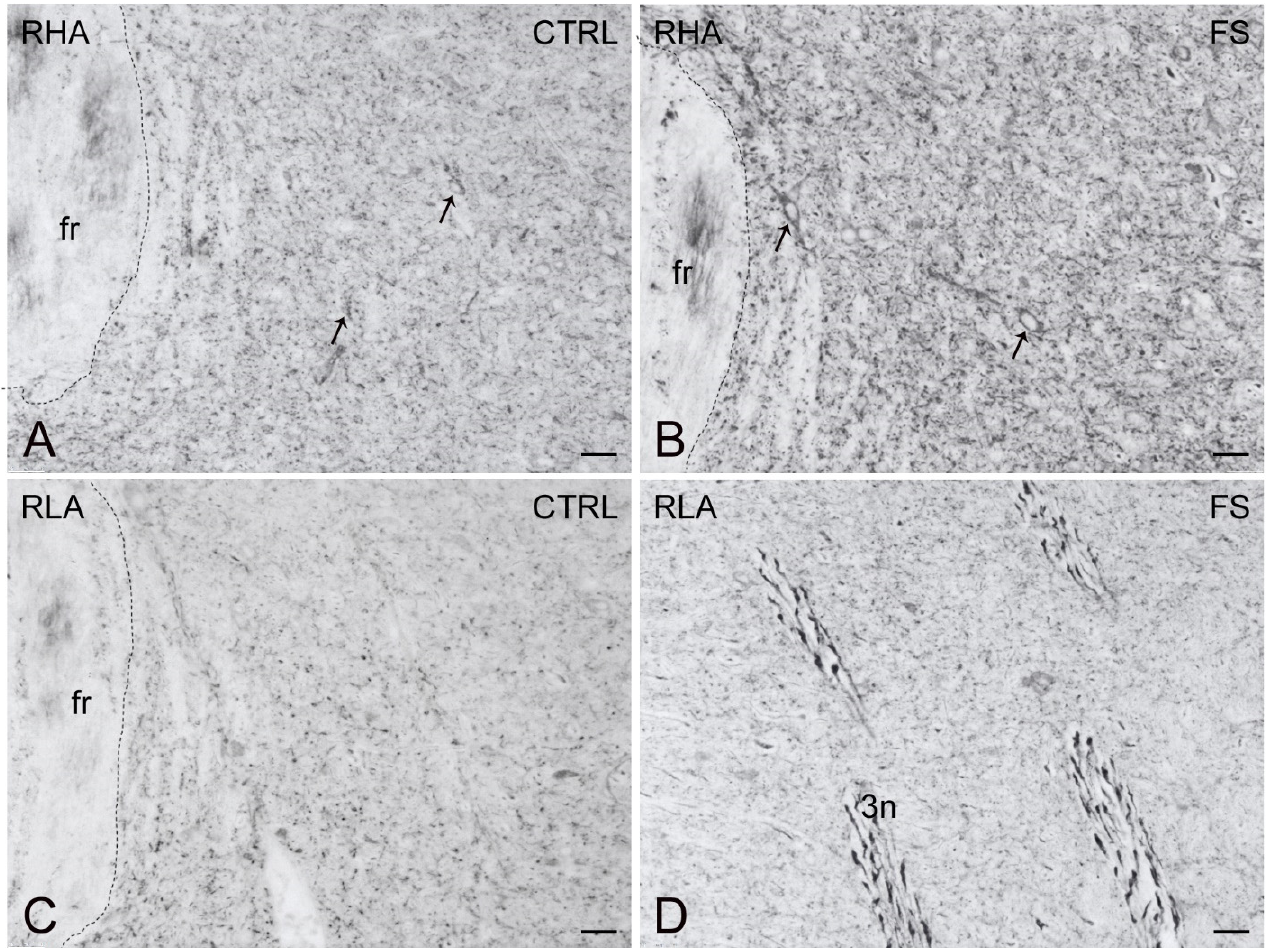
Figure 10. trkB receptor-like immunoreactivity (trkB-LI) in the ventral tegmental area (VTA) of RHA ( A , B ); and RLA rats ( C , D ) under baseline conditions (CTRL) and after a 15 min session of forced swimming (FS). Arrows in ( A , B ) point to labelled perikarya. fr, fasciculus retroflexus; 3n, oculomotor nerve. Scale bars: 25 µm.